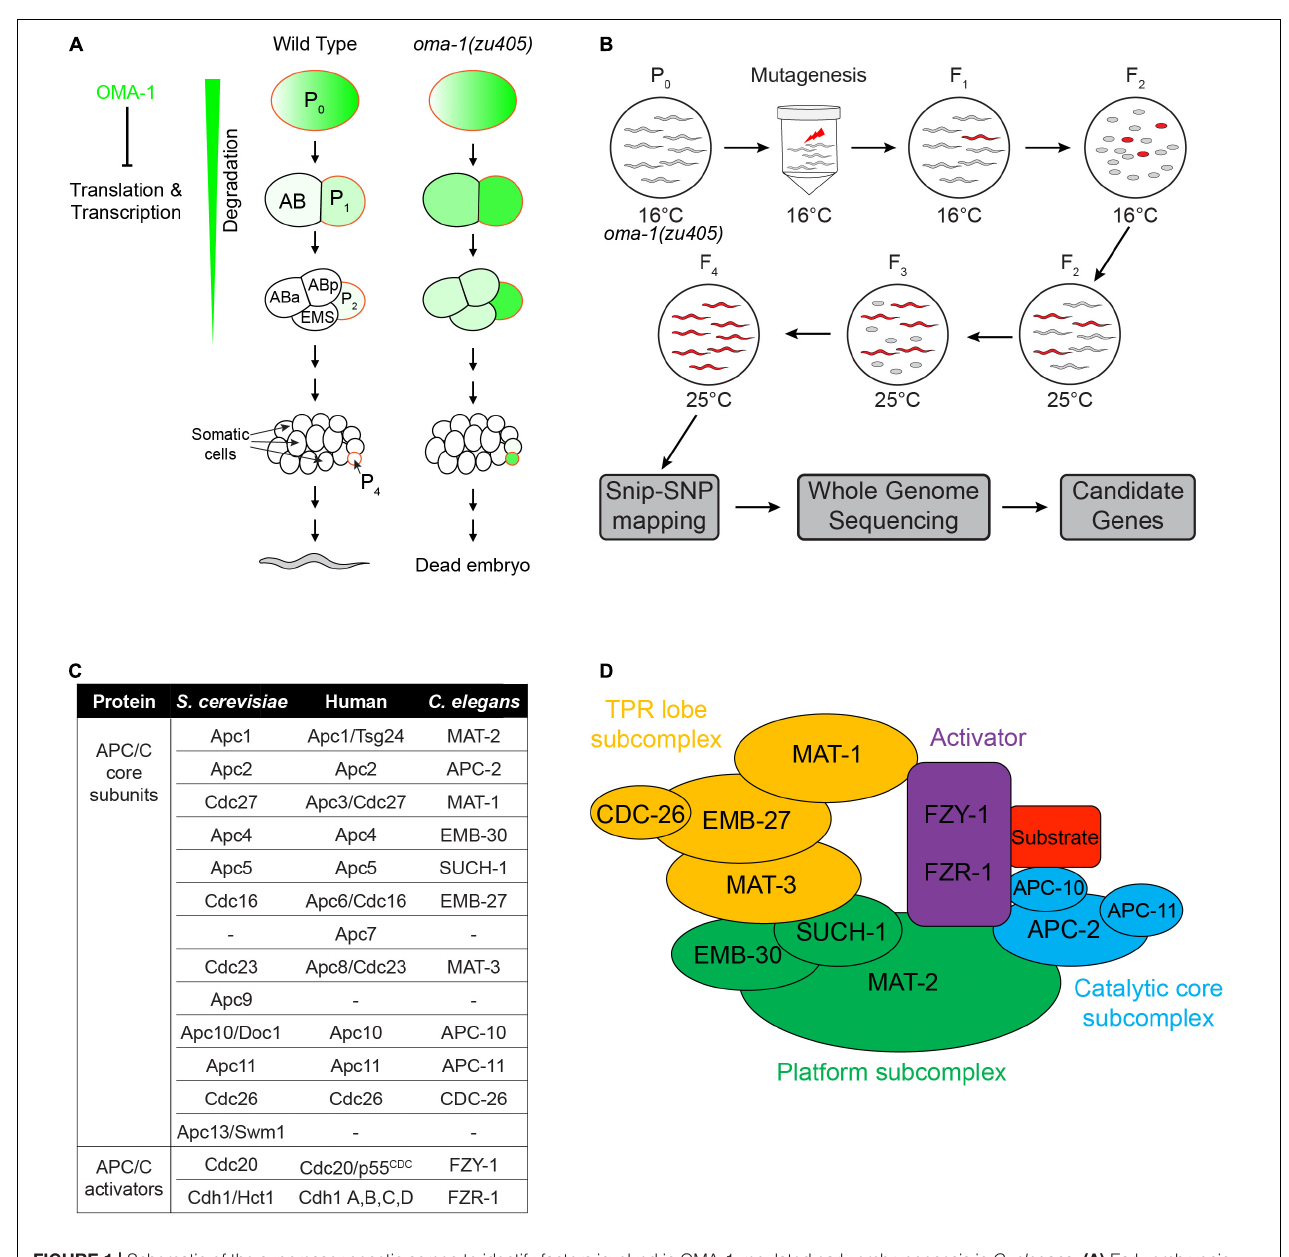
FIGURE 1 | Schematic of the suppressor genetic screen to identify factors involved in OMA-1-regulated early embryogenesis in C. elegans . (A) Early embryonic development from a 1-cell to an ∼ 20-cell stage embryo in the wild type and oma-1(zu405) mutant, highlighting the expression of OMA-1 in P 0 and P 1 cells and delayed degradation in P 2 and P 4 cells. (B) Suppressor screen schematic. Synchronized oma-1(zu405) L4 animals were exposed to the mutagen, and phenotypes were scored in F 3 and F 4 at 25 ◦ C. Snip-SNP mapping and whole genome sequencing were performed to determine candidate genes. (C) Homologs of